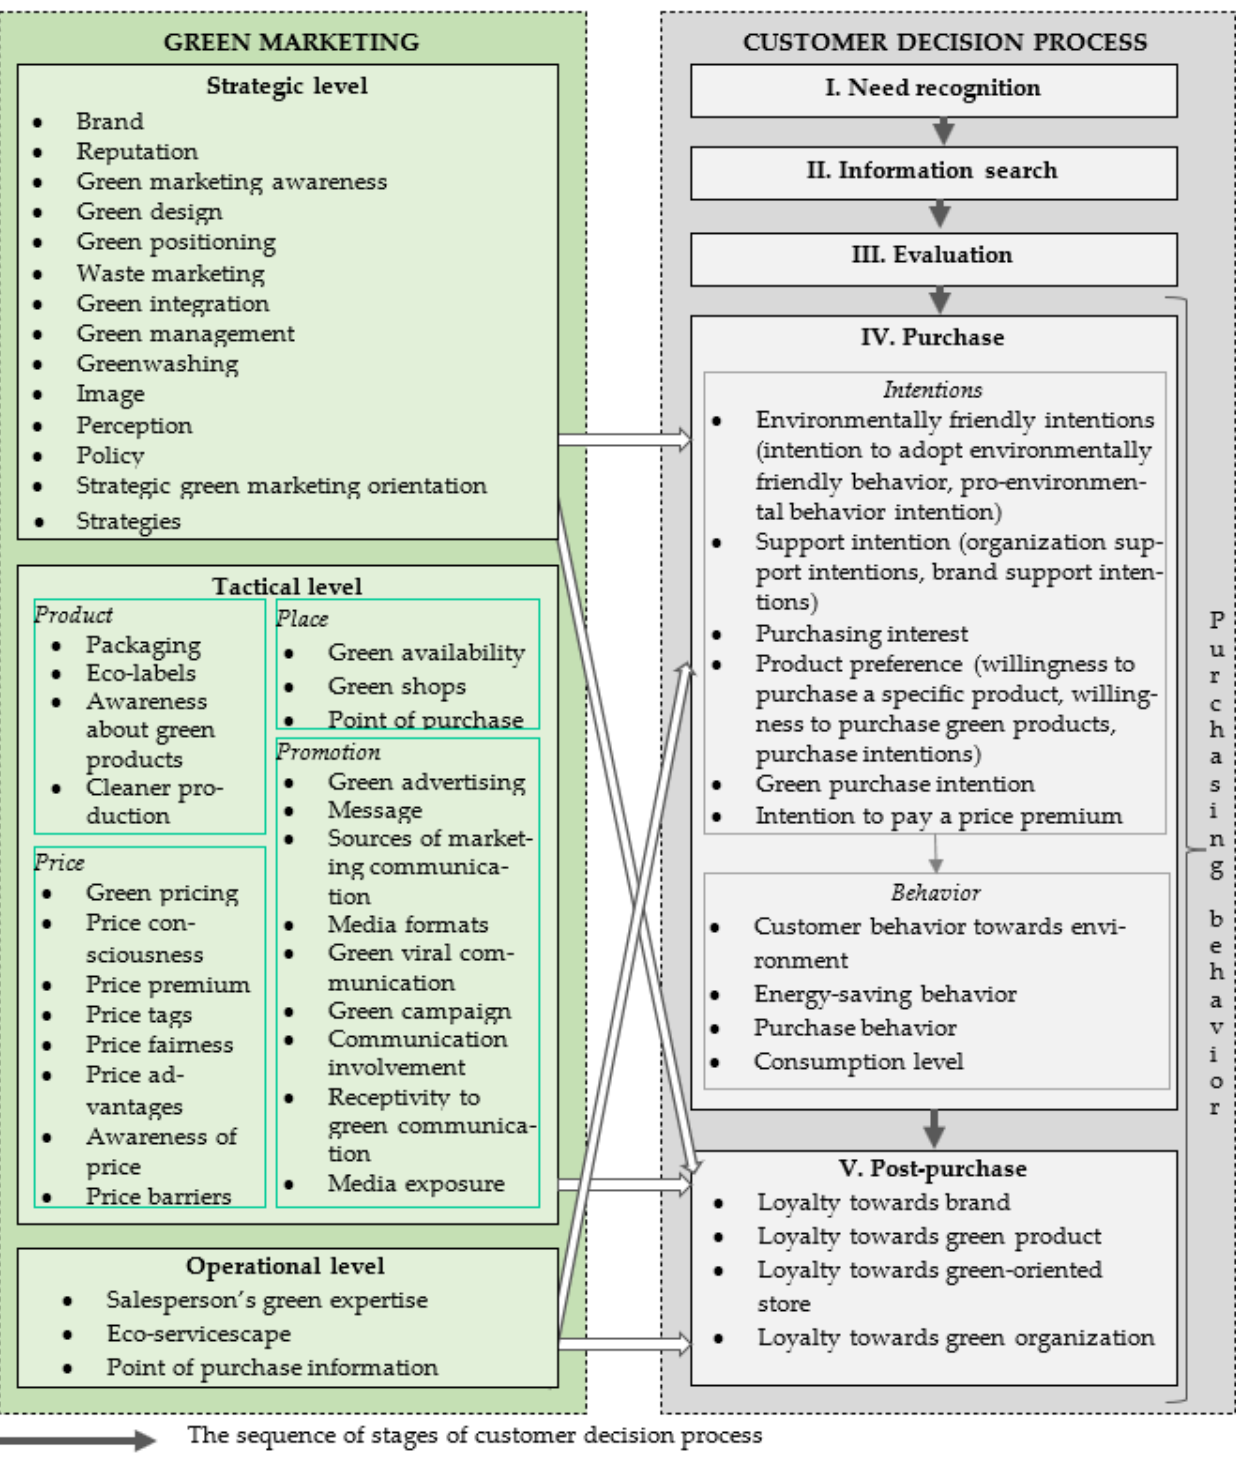
Figure 4. The researched paths between green marketing and customers’ purchasing behavior.